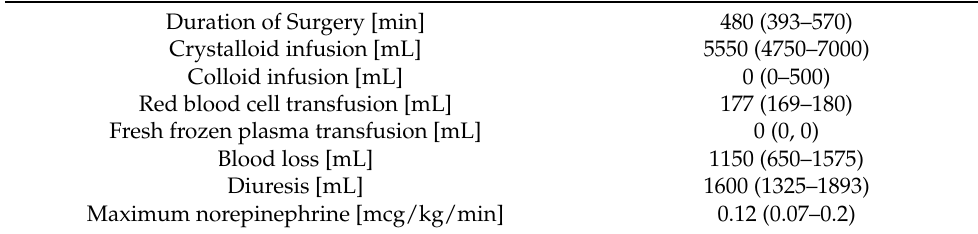
Table 2. Clinical data concerning perioperative fluid balance. Data are presented as median [in- terquartile